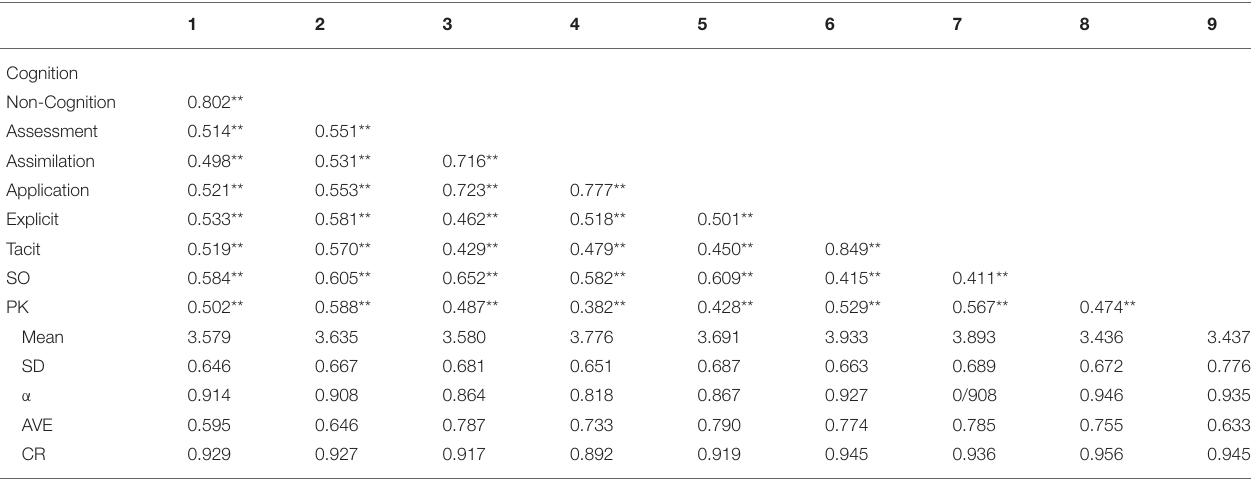
TABLE 1 | Measurement